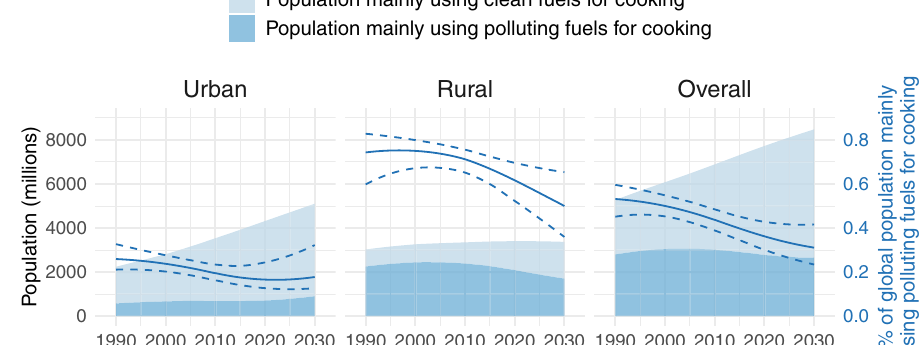
Fig. 2 Global use of clean and polluting fuels as the main fuel for cooking. Estimated (posterior median) global populations mainly using clean and polluting fuels for cooking (shaded area), shown alongside the estimated (posterior median) percentage of the global population mainly cooking with polluting fuels (solid line), with 95% posterior uncertainty intervals (dotted lines).